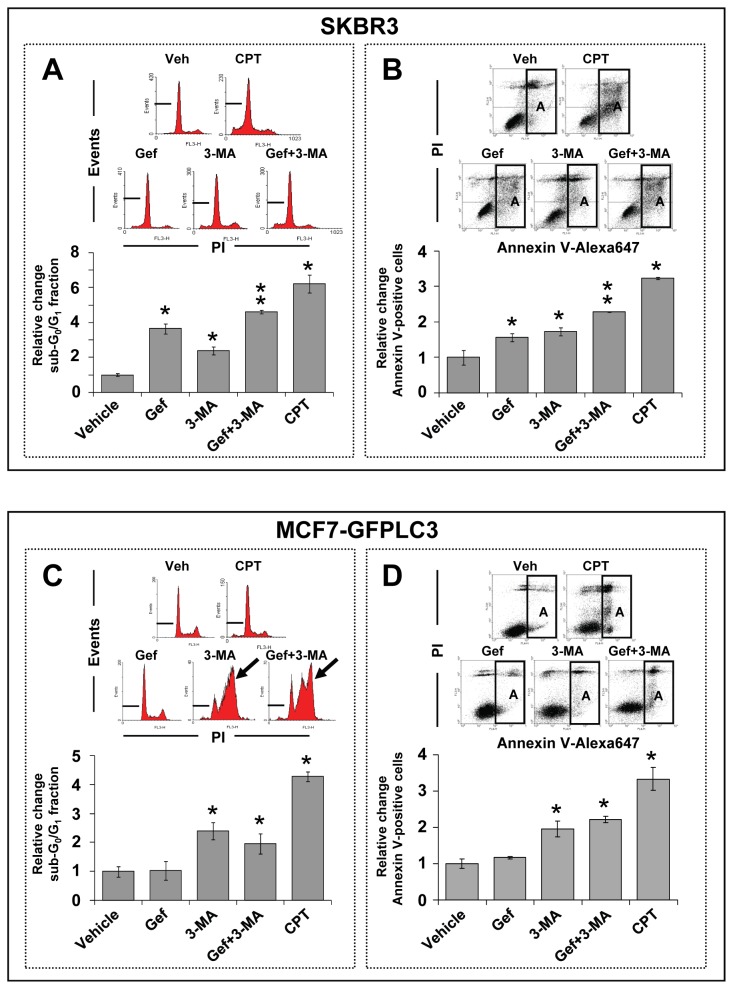
3-MA sensitized SKBR3 but not MCF7-GFPLC3 cells to cell death in the presence of gefitinib.Flow cytometric analysis of apoptosis in SKBR3 (A and B) and MCF7-GFPLC3 (C and D) cells treated for 72 h with vehicle or 10 µM gefitinib (Gef), in the absence or presence of 5 mM 3-MA. Camptothecin (CPT) at 5 µM was used as an inducer of apoptosis (positive control). (A and C) Analysis of the sub-G0/G1 apoptotic cell fraction. The inserted histograms show representative DNA profiles of cells treated with the indicated agents where a sub-G0/G1 cell fraction is indicated with a marker. Arrows in (C) indicate S-G2/M cell cycle block. (B and D) Analysis of apoptosis in cells stained with Annexin V-Alexa647 and PI. The inserted representative dot plots show distribution of cell populations treated with the indicated agents where apoptotic Annexin V-positive cells are marked as “A” in a rectangular region. Bar graphs represent the data (mean±SD) from 3 independently stained samples and show fold change relative to the vehicle-treated controls expressed as 1. Asterisks indicate a statistically significant difference (p<0.05) between cells treated with the vehicle and indicated agents. A double asterisk indicates a statistically significant difference (p<0.05) between cells treated with gefitinib in the presence of 3-MA and single-agent treated cells in addition to a statistically significant difference when compared to the vehicle-treated cells. Representative experiments are shown.